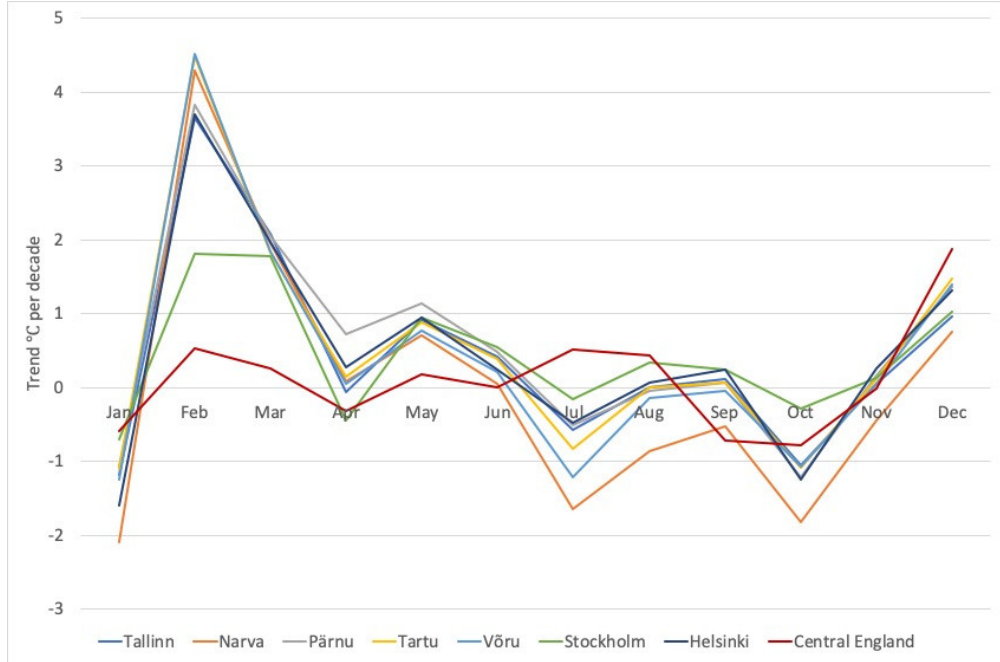
Figure 11. Trends of average monthly surface air temperatures from 2005 to 2019 in the different cities of the central Baltic area and in central England.